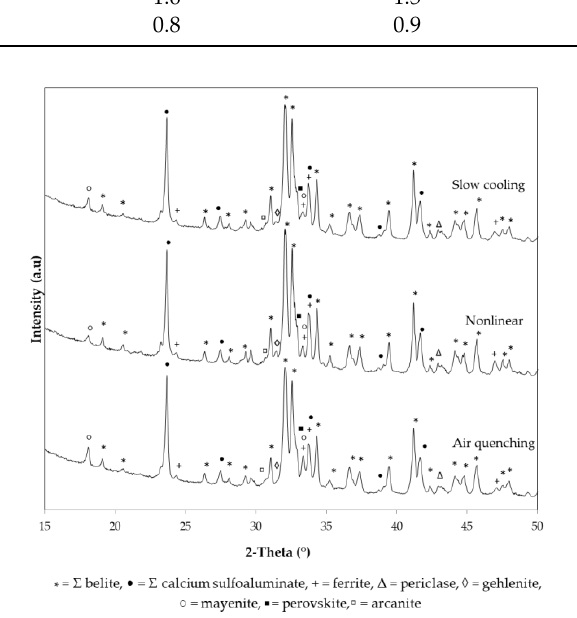
ff raction patterns of cement clinkers with di ff erent cooling Figure 2. X-ray diffraction patterns of cement clinkers with different cooling regimes. Figure 2. X-ray di